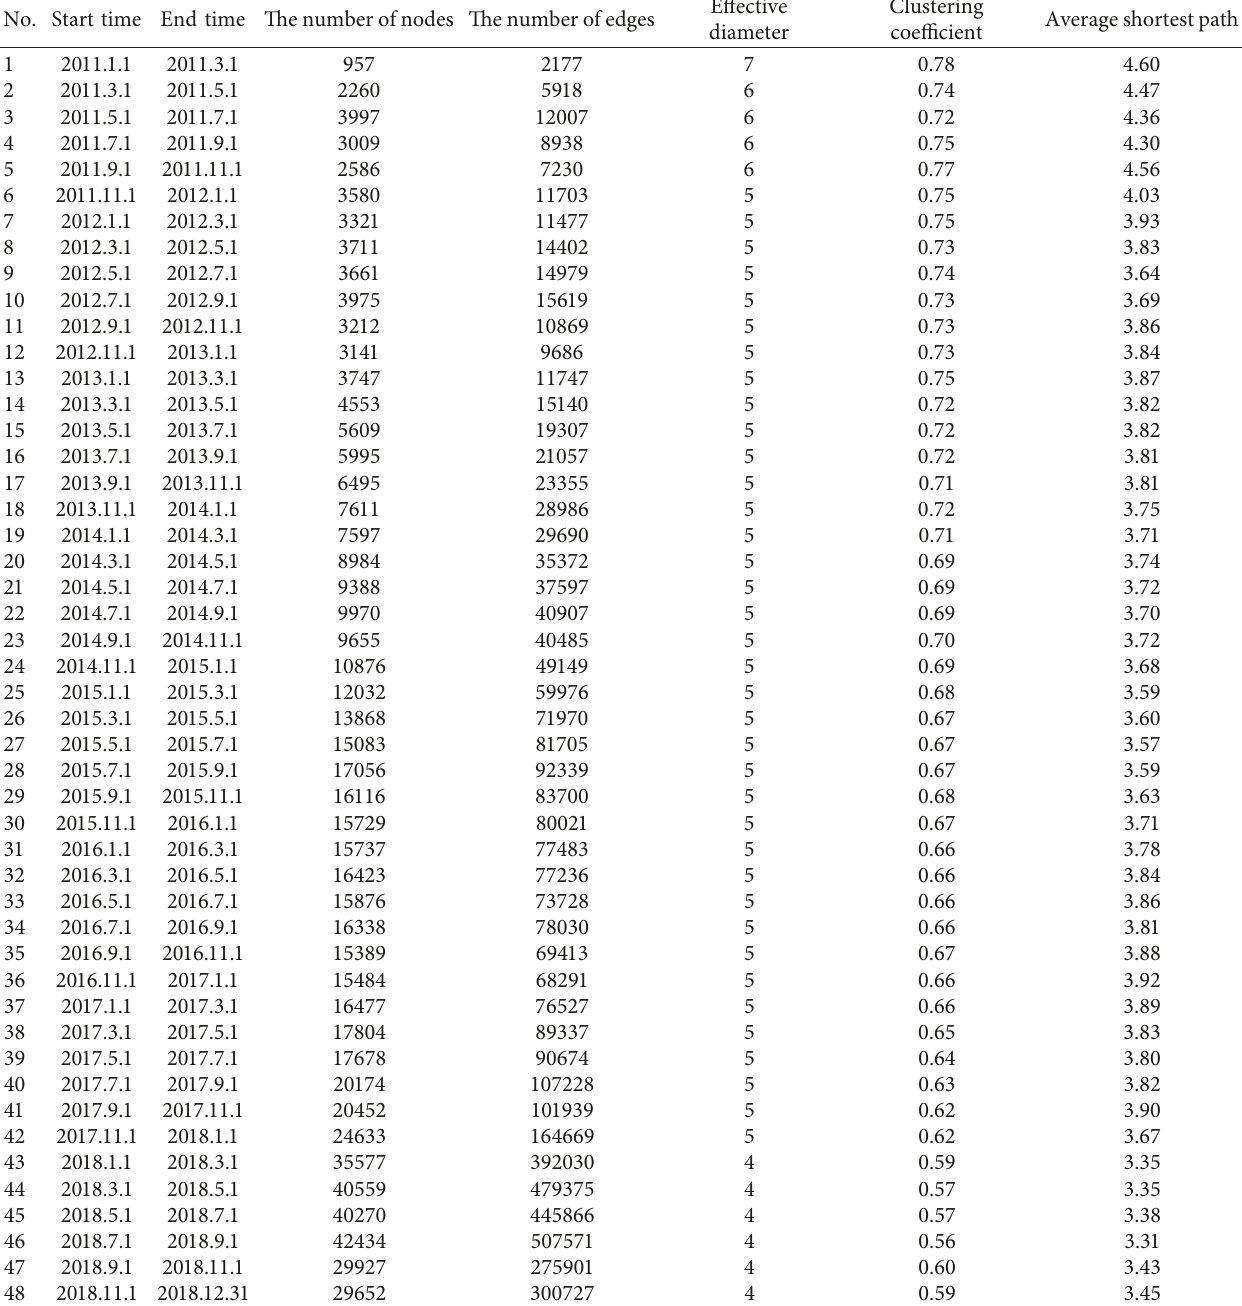
Table 1: The structural characteristics of 48-network